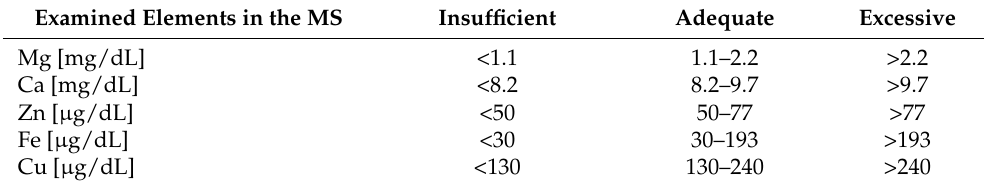
Table 2. Reference values of the concentration of examined macro- and microelements in blood serum for women in the 3rd trimester of pregnancy